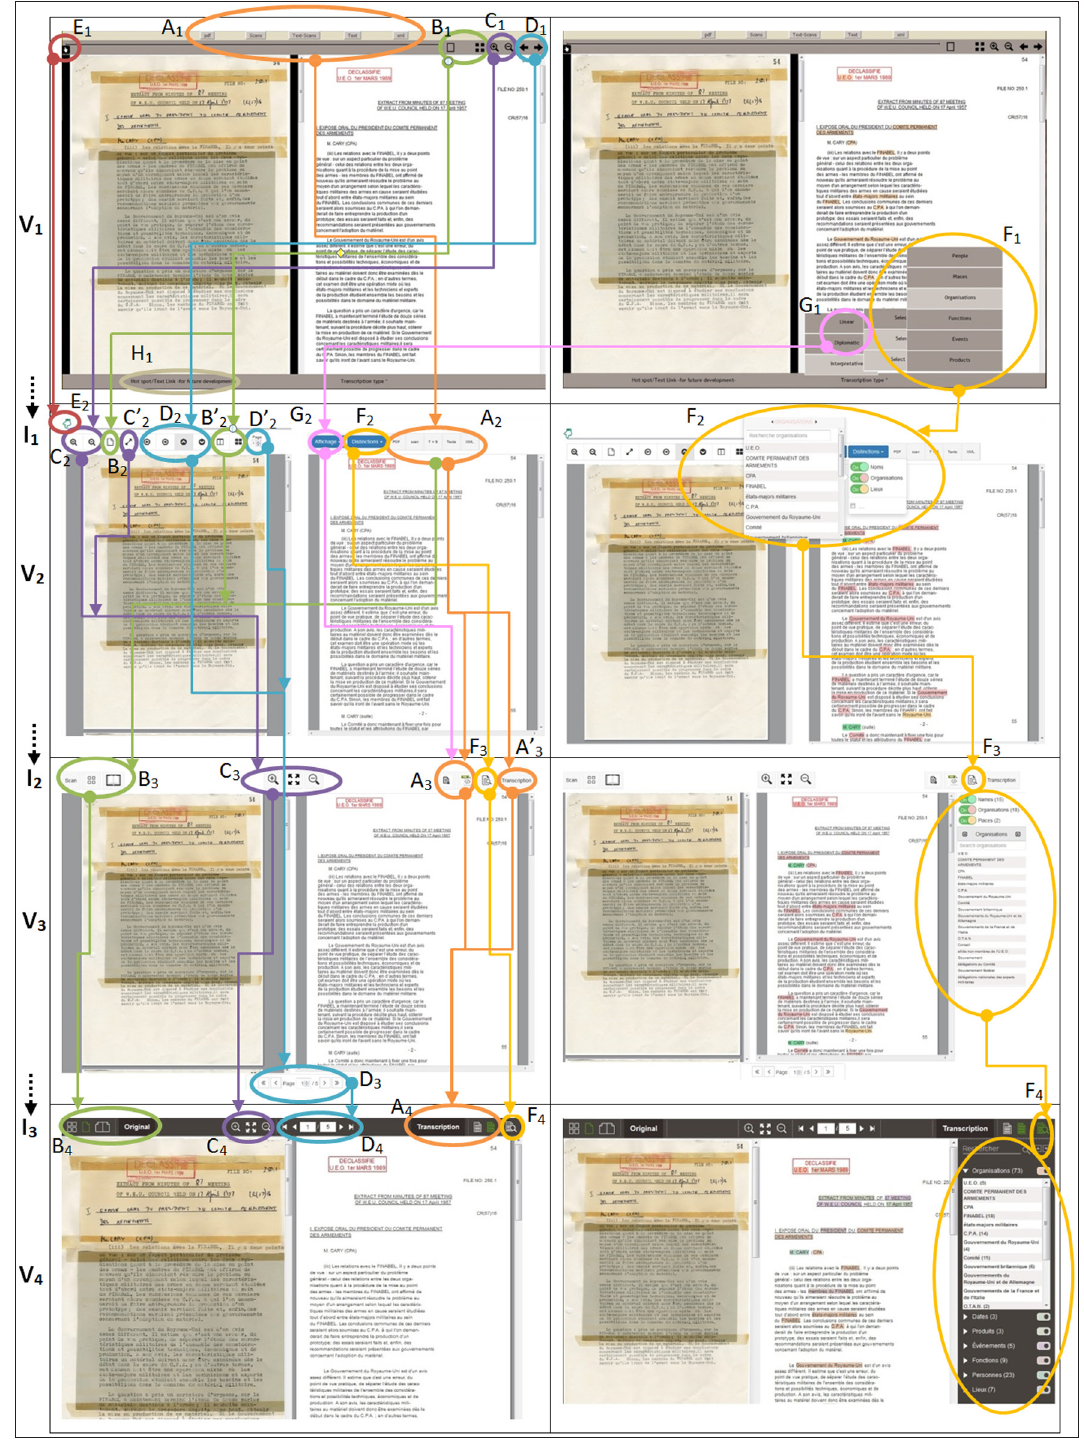
–V ), iterations (I 1 4